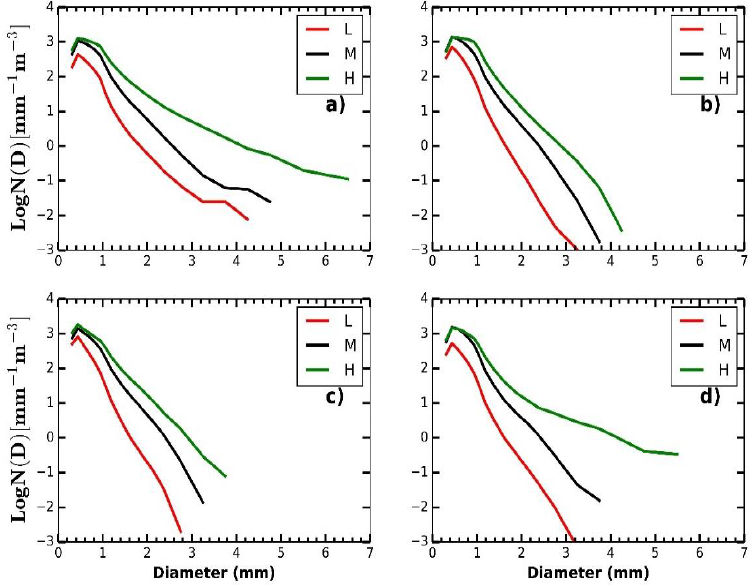
Figure 4. Diurnal variation of the RSD spectra in function to rainfall classes (light rainfall, medium rainfall, and heavy rainfall), ( a ) 15 – 20 LST, ( b ) 21 – 02 LST, ( c ) 03 – 08 LST, ( d ) 09 – 14 LST.